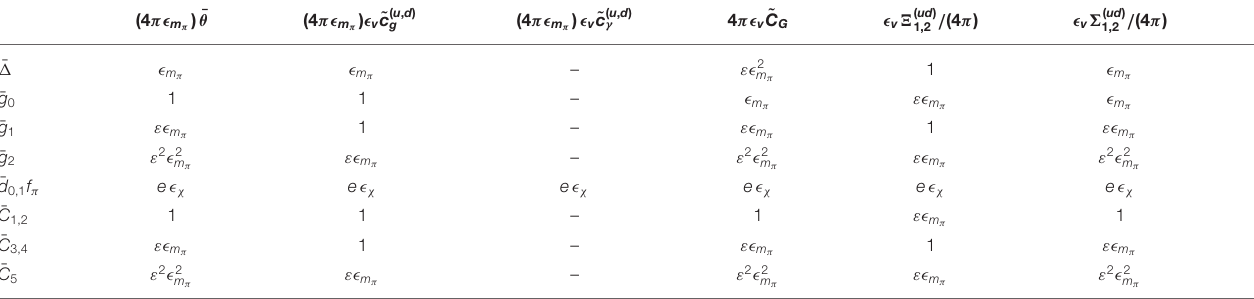
TABLE 1 | Scaling of the LECs in the chiral Lagrangian in dependence of the microscopic CP violation sources. ) ¯ (4 πǫ m π